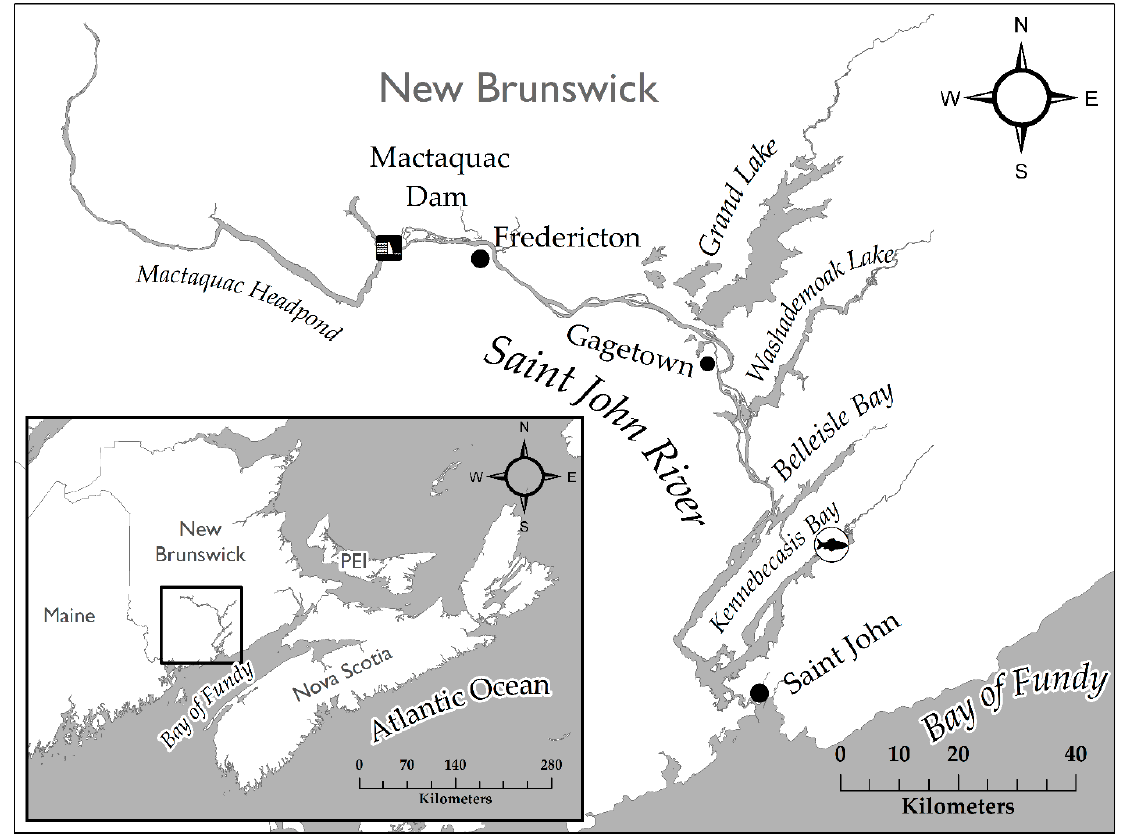
Figure 1. Saint John River, New Brunswick, extending 150 km from the river mouth at the City of Saint John, upstream to the Mactaquac Dam west from the City of Fredericton. Saltwater influence extends to the village of Gagetown. The four major tributaries including Grand Lake, Washademoak Lake, Belleisle Bay and the Kennebecasis Bay are also included. The previously known Shortnose Sturgeon winter aggregation at the head of Kennebecasis Bay and confluence of the Hammond River is indicated by the fish symbol. PEI in the map inset indicates Prince Edward Island.